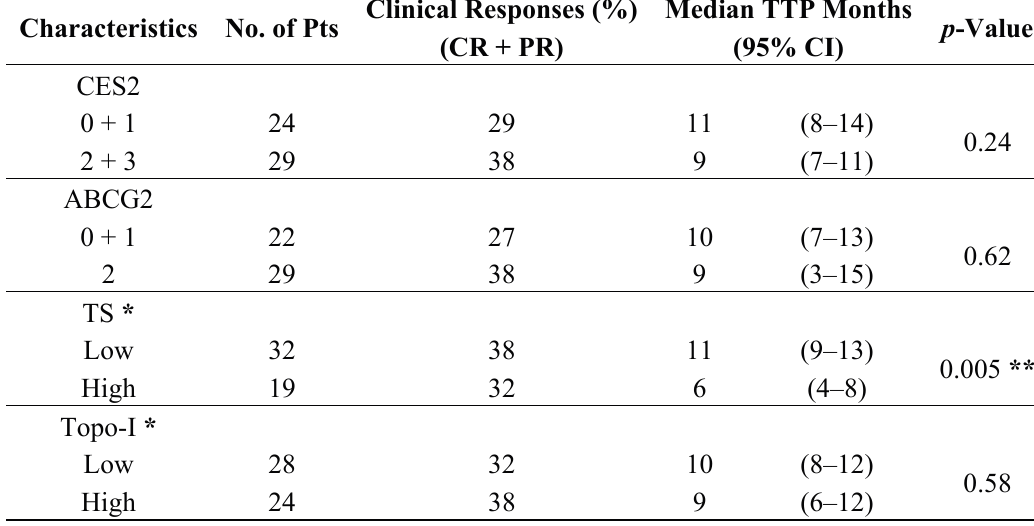
Table 2. Univariate analysis considering protein expression with respect to survival in a series of 58 metastatic colorectal cancer patients treated with FOLFIRI.